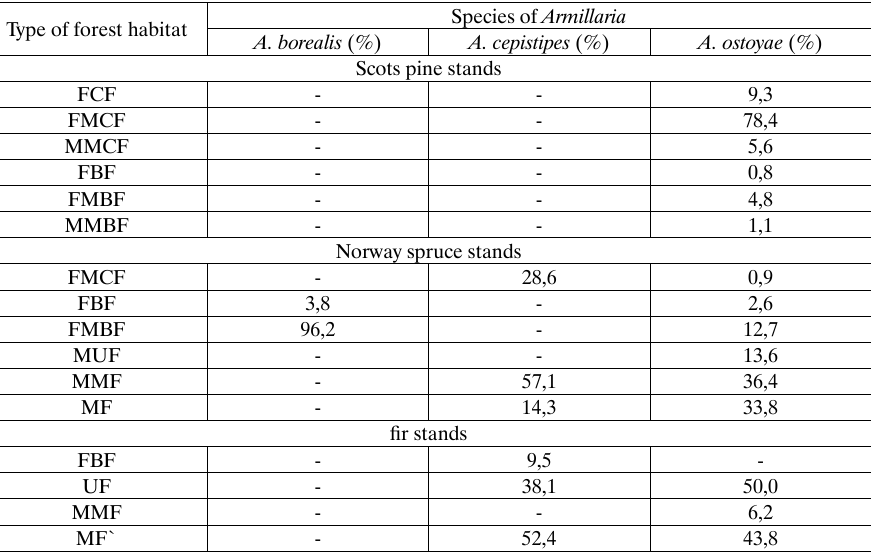
Percentage of particular Armillaria species in samples from coniferous stands from different